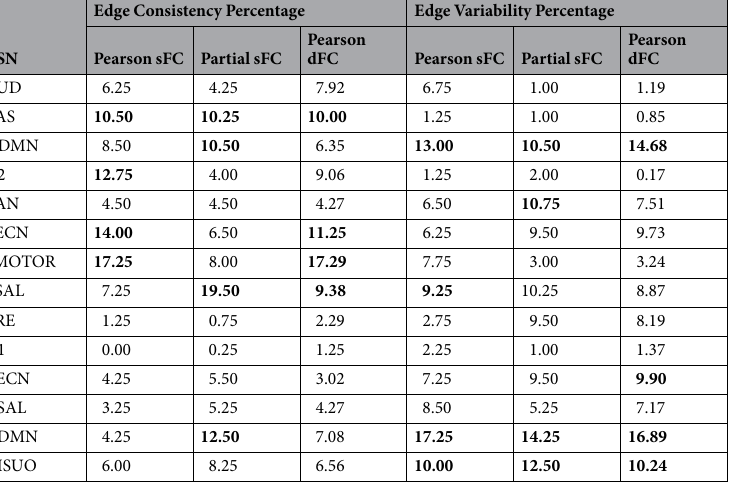
Table 2. Edge consistency (5 percentile threshold) and edge variability (95 percentile threshold) percentages for RSNs (top four contributing RSNs are shown in bold font). AUD-Auditory, BAS-Basal Ganglia,